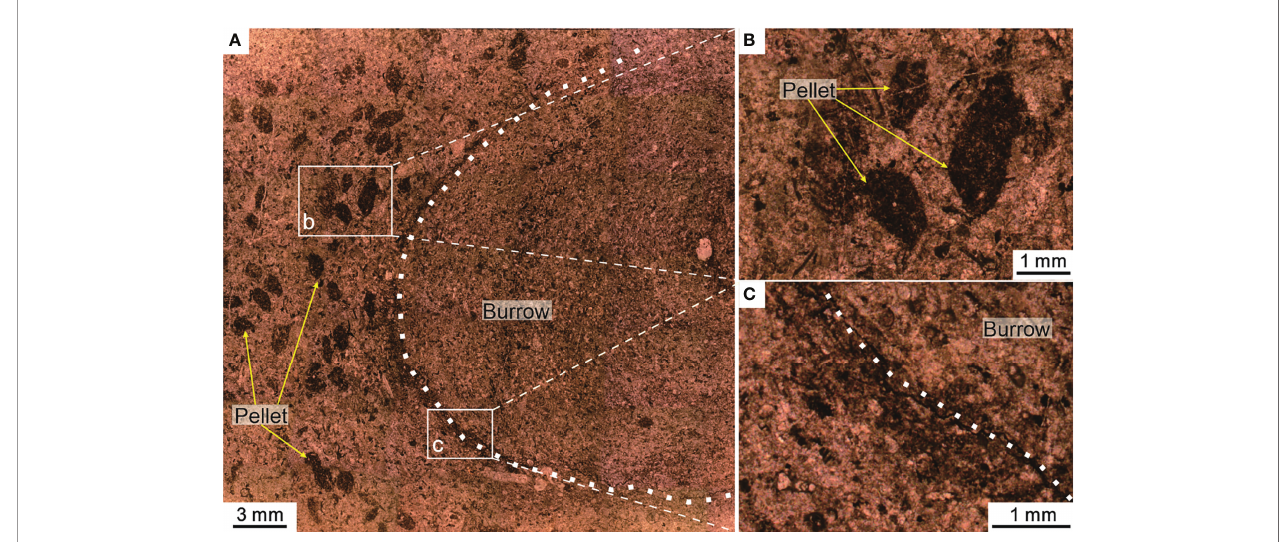
FIGURE 8 | Trace fossil (burrow) and fecal pellets from Bed 6 of the Chibi section before the PTME. (A) The cross-section of a burrow and the well-demarcated boundary (dotted line). Panels (B, C) are the magni fi ed images from the two white boxes in panel (A)